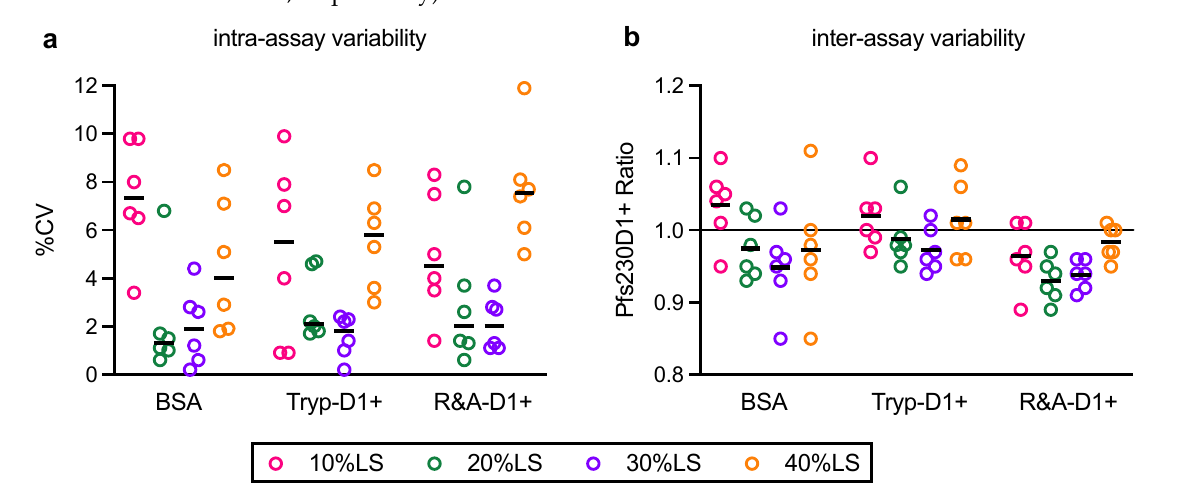
Figure 4. Intra- and inter-assay variability. AIA was performed as described in Figure 3, and %CV in triplicate wells ( a ) and Pfs230D1+ Ratio ( b ) in each assay (dots) are shown. The bars represent median in ( a ) and mean in ( b ). The assays with BSA were performed by a single operator (6 inde- pendent assays), while Tryp-D1+ and R&A-D1+ were tested by two operators (3 independent assays per operator).